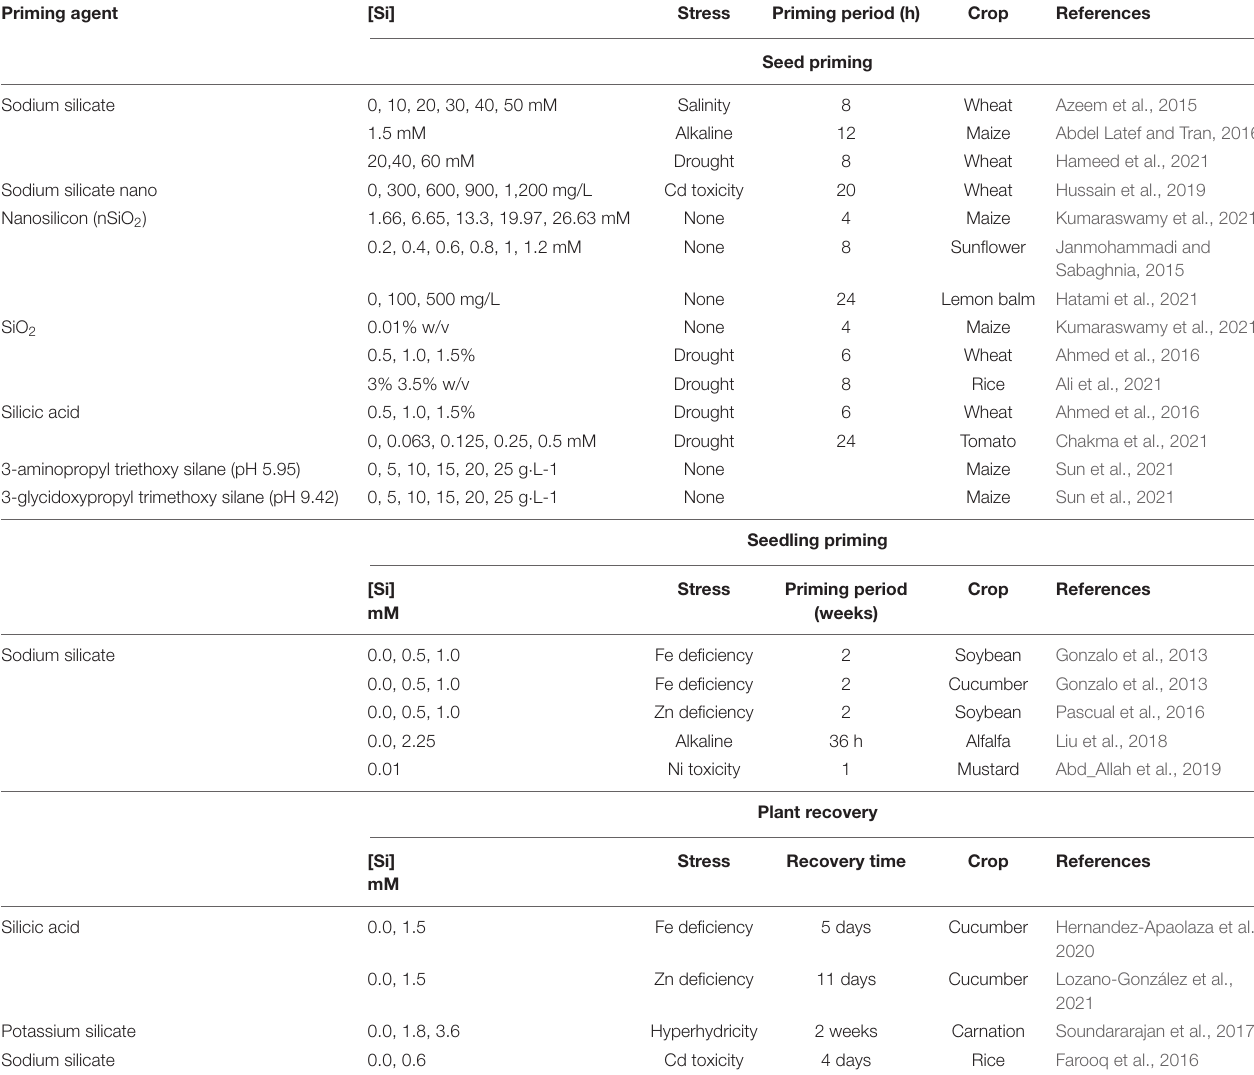
TABLE 2 | Different Si sources use for priming and control abiotic stresses.